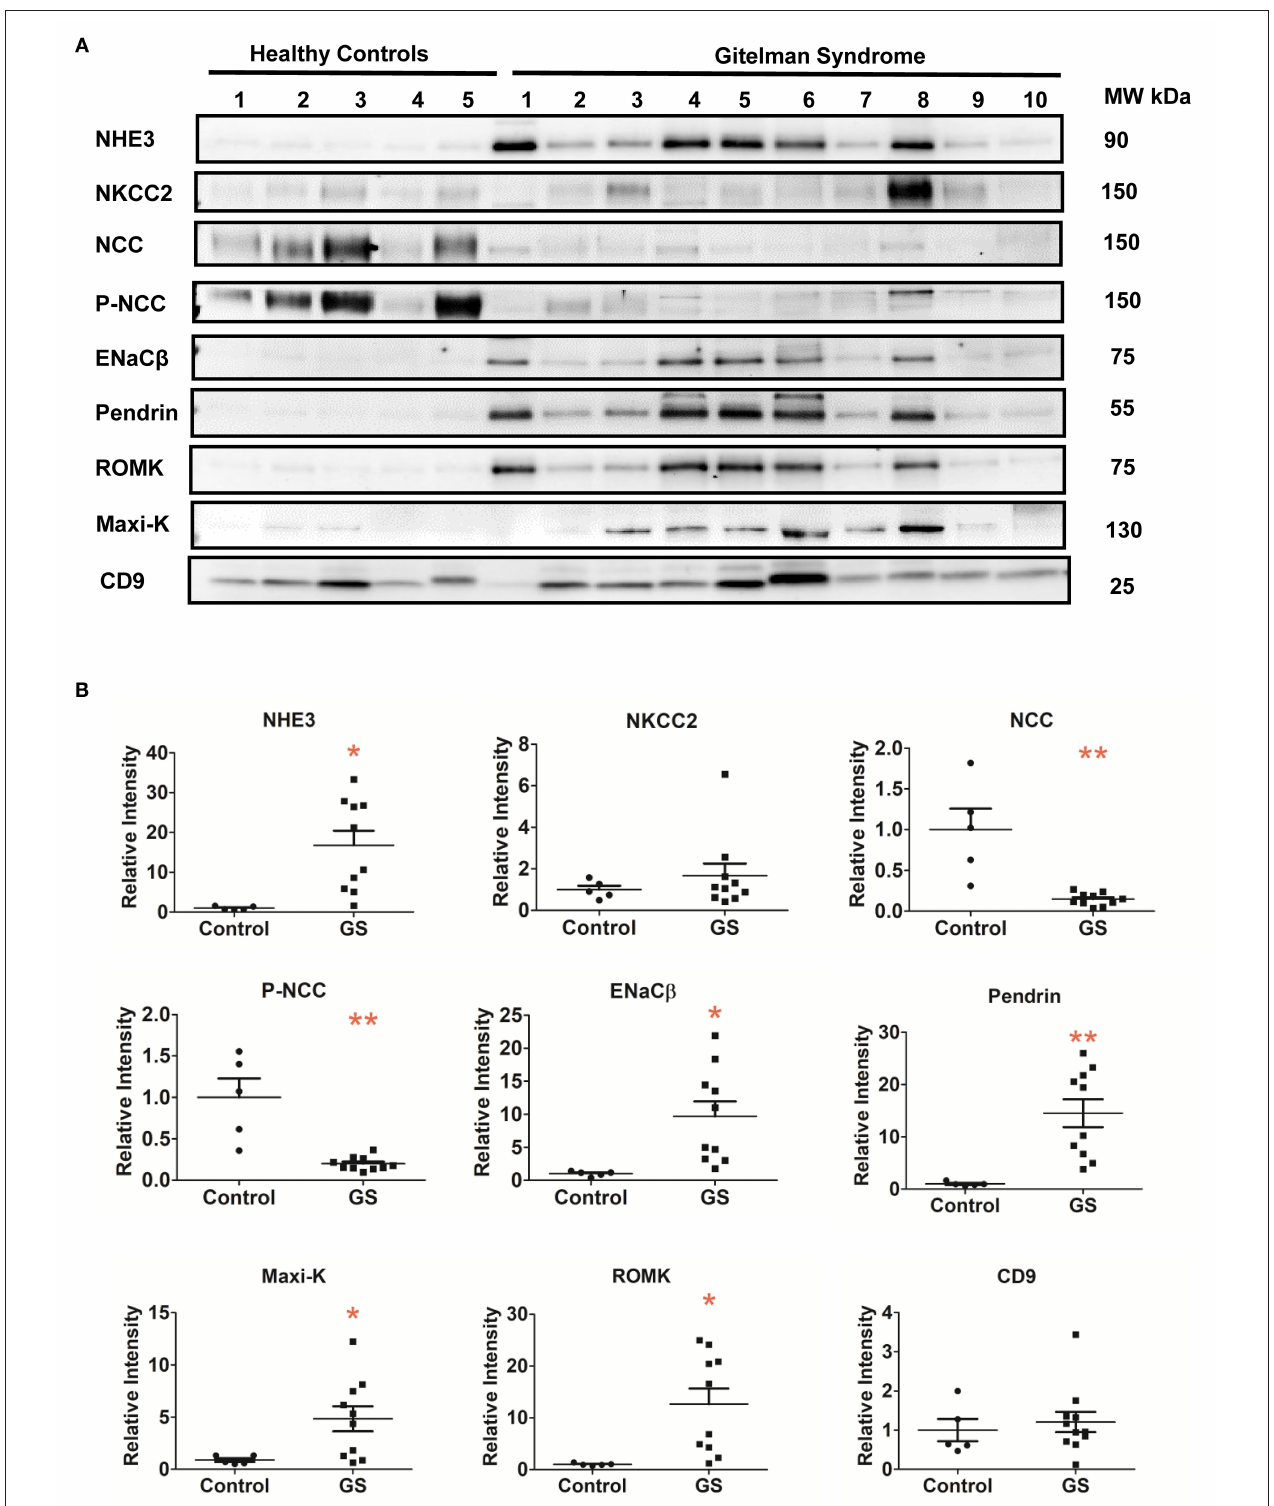
FIGURE 2 | Renal Na + and K + associated transporters expression from urinary extracellular vesicles in patients with GS ( n = 10) compared with healthy controls. (A) Immunoblotting of renal transporters (NHE3, NKCC2, NCC, p-NCC, ENaC β , pendrin, ROMK, Maxi-K, and CD9). (B) Quantification of immunoblotting of NHE3, NKCC2, NCC, p-NCC, ENaC β , pendrin, ROMK, Maxi-K, and CD9. Error bars, standard deviation. * P < 0.05, ** P < 0.01.